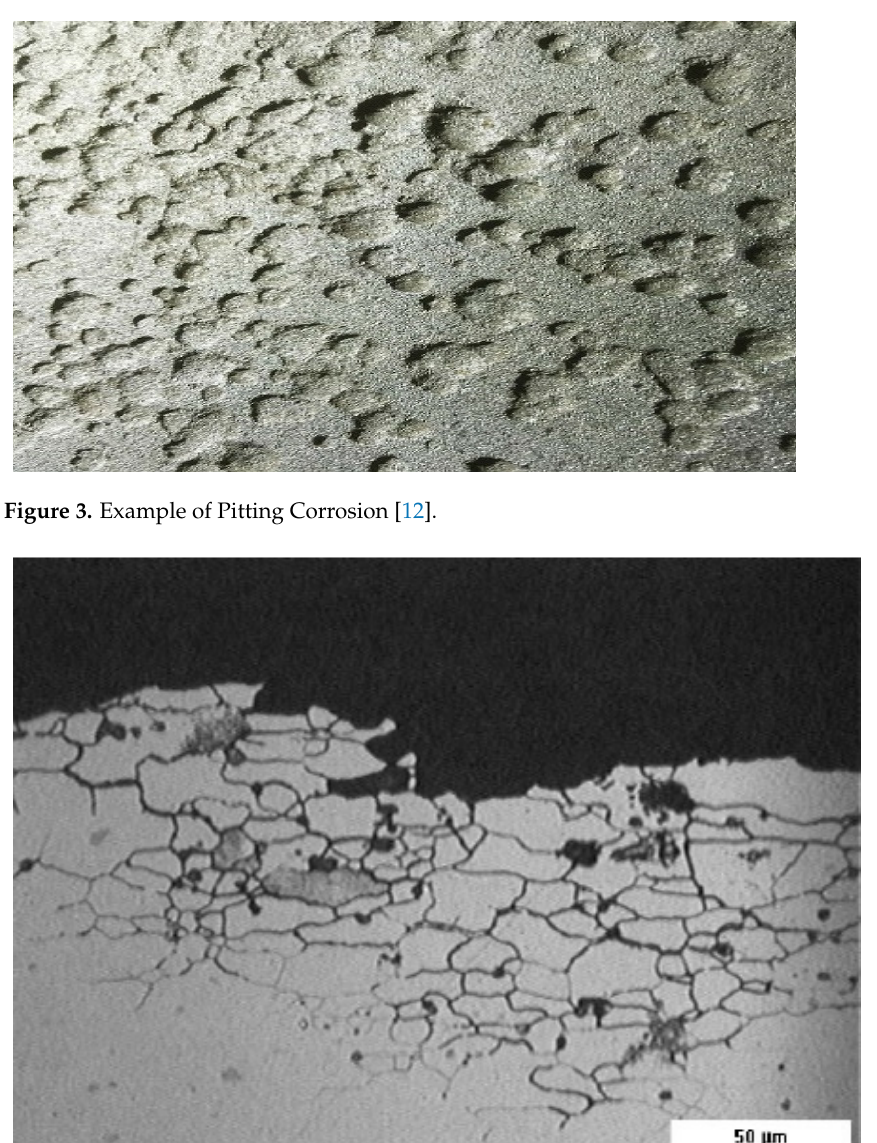
Figure 3. Example of Pitting Corrosion [12].